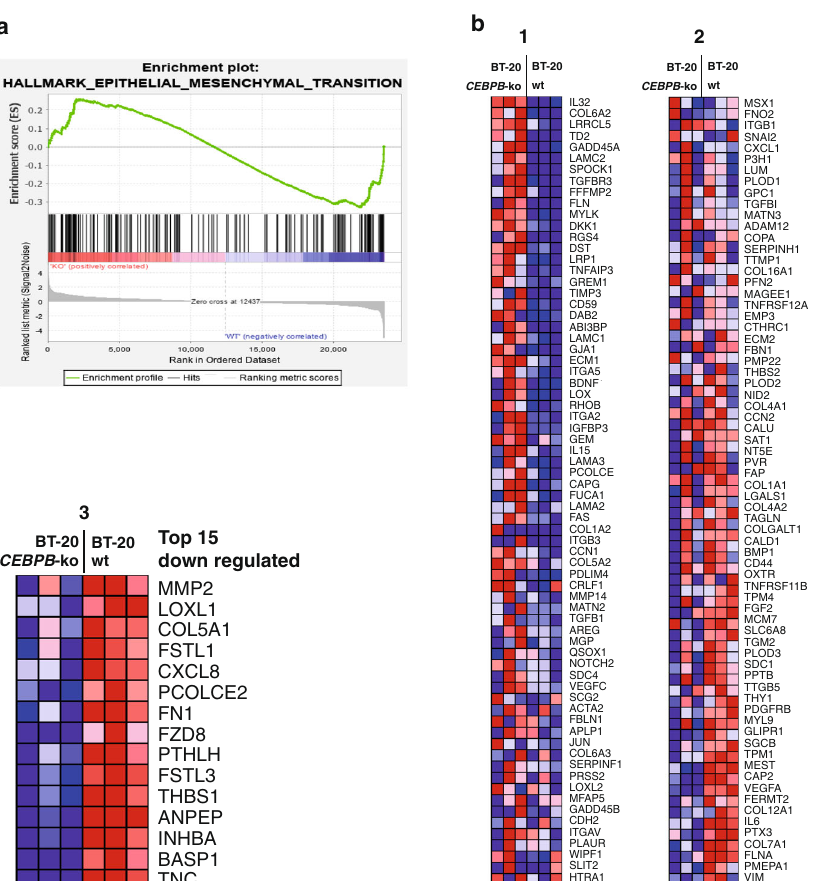
Fig. 5 Regulation of ECM genes by C/EBP β . a Gene Set Enrichment Analysis (GSEA) plot of Hallmark Epithelial-Mesenchymal Transition (EMT) gene set. b Heatmap of differentially expressed genes from the (EMT) gene set in ( a ) between BT-20 CEBPB -ko cells vs BT-20 WT cells split in three parts with in the third (3) enlarged part the top 15 downregulated leading-edge